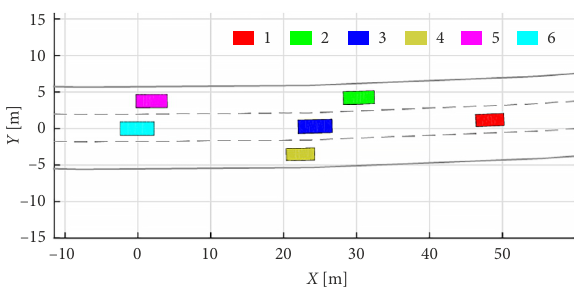
Figure 13. Projection clearances and safe distances